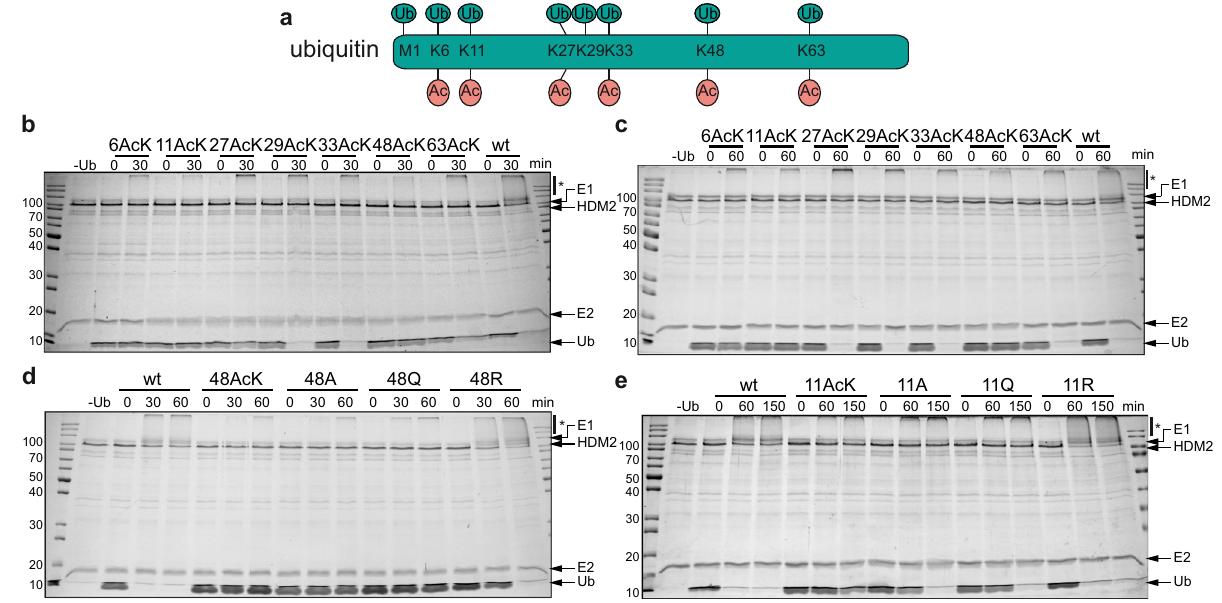
Fig. 1 | Acetylated Ub variants and their performance in HDM2 auto- ubiquitylation. a Lysine residues of ubiquitin (Ub) used for Ub chain formation and acetylation (Ac) in cells. b, c Ub variants acetylated at K6 (6AcK), K11 (11AcK), K27(27AcK),orK48(48AcK)areinef fi cientlyusedbyHDM2forautoubiquitylation. d AutoubiquitylationassayswithUbvariants,inwhichK48wasreplacedbyA,Q,or R reveal thatthe presenceofa positive charge atposition 48 iscriticalfor ef fi cient HDM2 autoubiquitylation. e Autoubiquitylation assays with Ub variants, in which K11wasreplacedbyA,Q,orR,indicatethattheinef fi cientuseofUb11AcKbyHDM2 for autoubiquitylation cannot be explained by charge neutralization only.